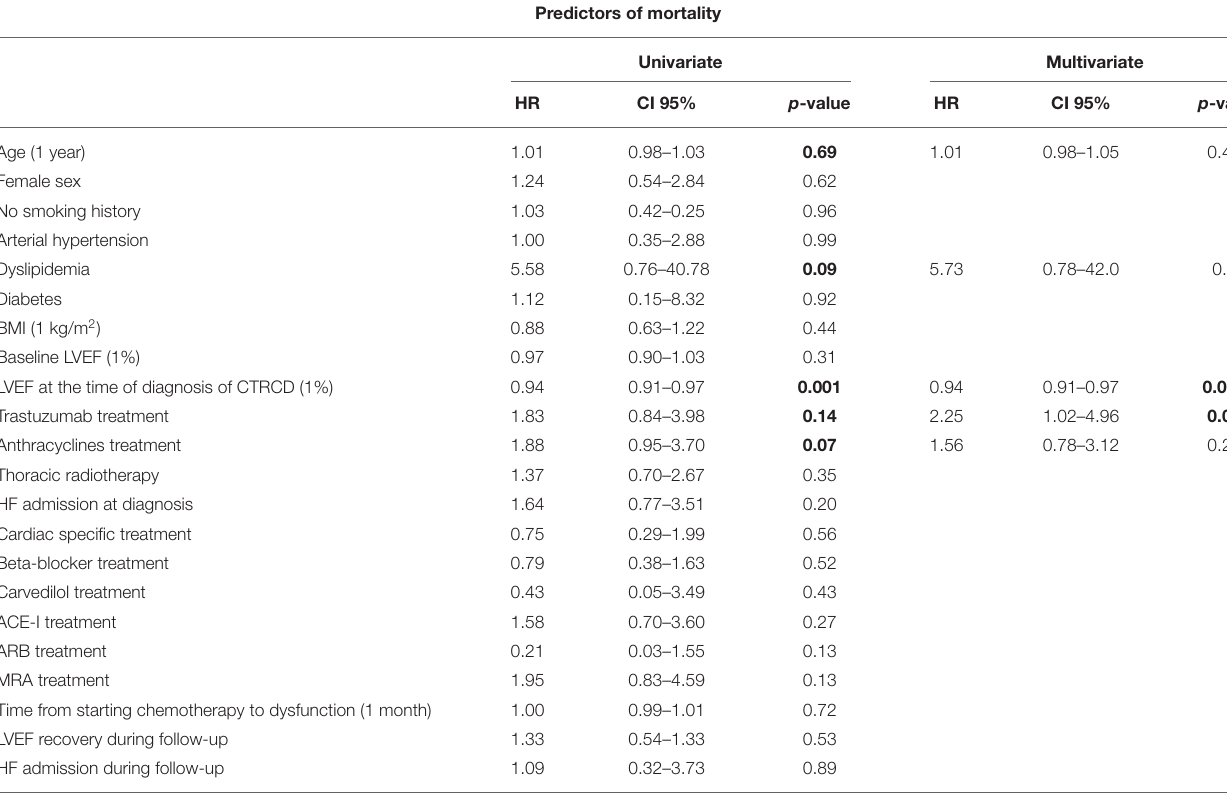
TABLE 6 | The Cox regression analysis to identify the predictors of mortality in the patients with cancer therapy-related cardiomyopathy. Predictors of mortality